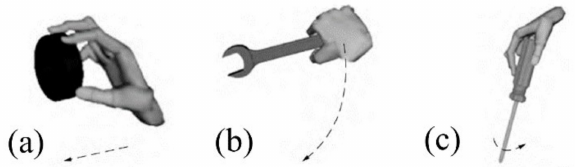
Figure 4. The types of typical assembly operations: ( a ) inserting, ( b ) fastening, and ( c ) screwing. The actions are demonstrated in Figure